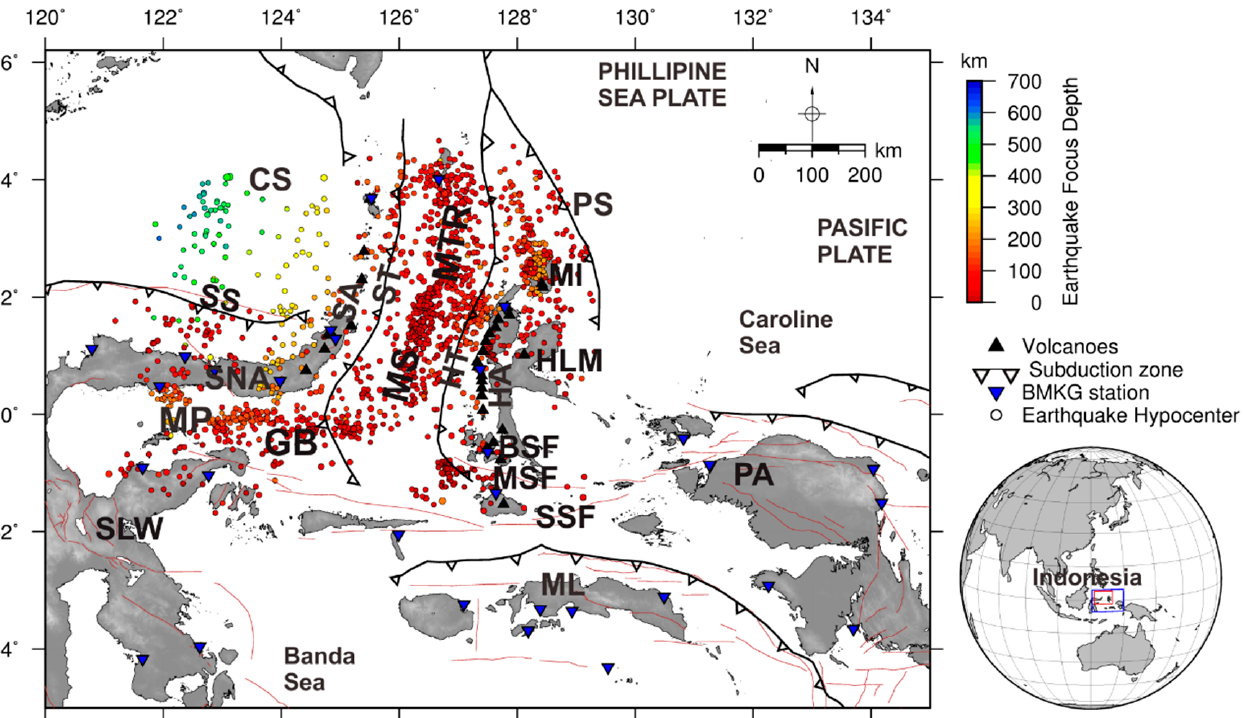
Figure 1. The horizontal distribution of seismic map of the research location around the Molucca Collision Zone. SLW: Sulawesi island; ML: Molucca island; PA: Papua island; HLM: Halmahera island; SNA: Sulawesi’s north arm; SS: Sulawesi slab; PS: Philippine slab; HT and ST: Halmahera and Sangihe Trench; HA and SA: Halmahera and Sangihe volcanoes arc; CS: Celebes sea; MP: Minahassa peninsula; GB: Gorontalo Basin; MS: Molucca Sea; MTR: Mayu-Talaud Ridge; BSF, MSF, and SSF: Bacan, Molucca, and Sula Sorong Faults, respectively.